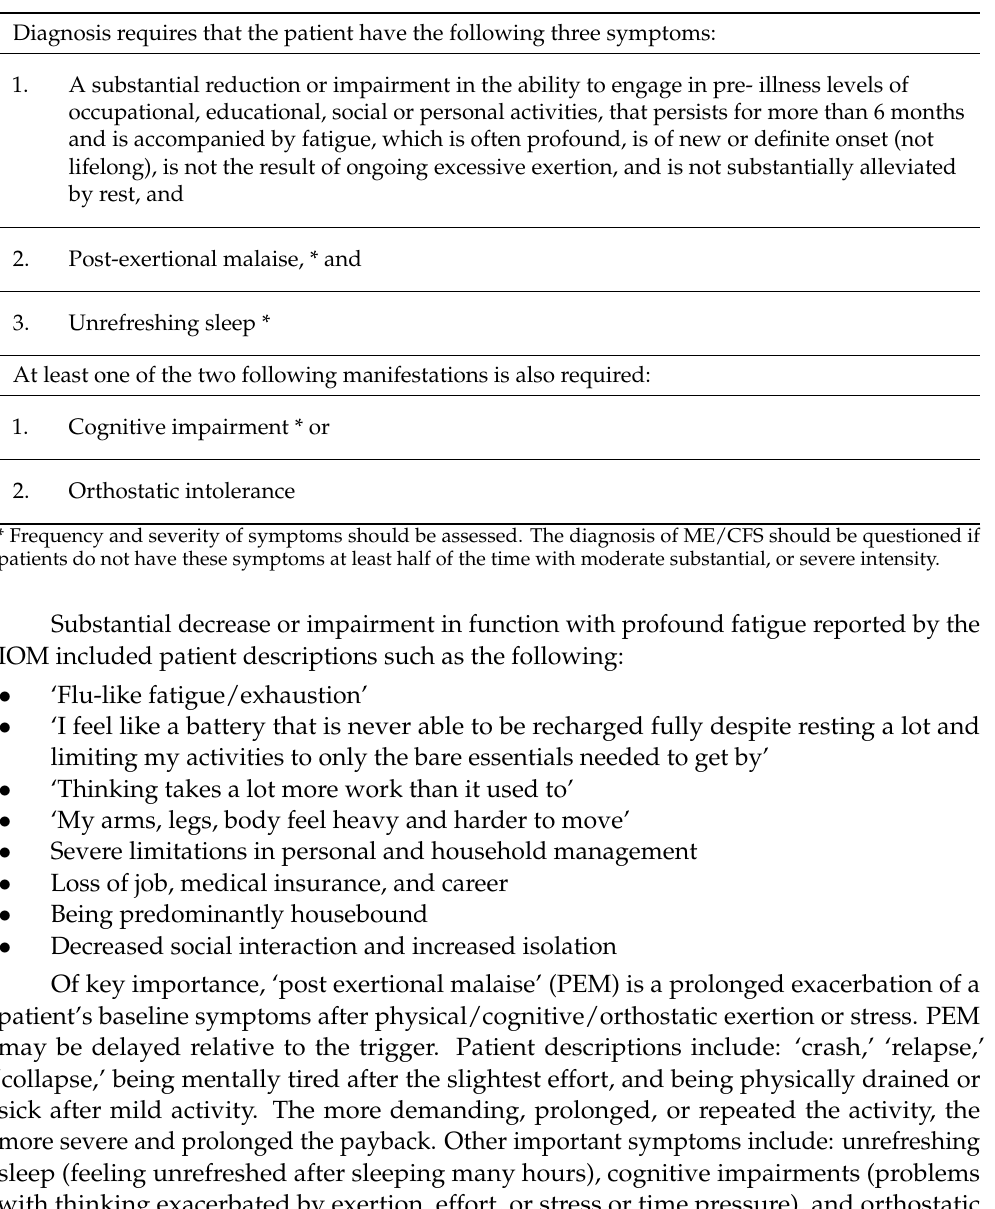
Table 1. Proposed diagnostic criteria for ME/CFS